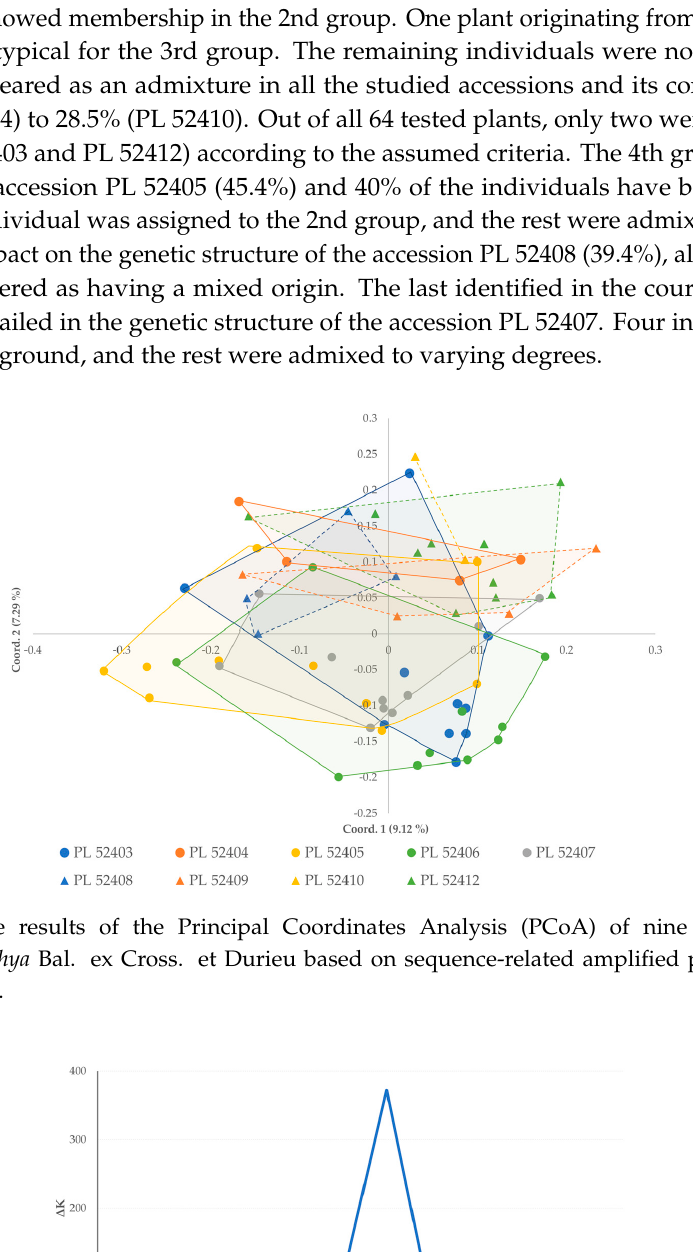
Figure 5. Results of the optimal population model investigation by plotting ad hoc measure ∆ K of the data over ten runs generated by CLUMPAK software [31] The analysis performed for nine accessions of Avena macrostachya Bal. ex Cross. et Durieu based on sequence-related amplified polymorphism (SRAP) markers.